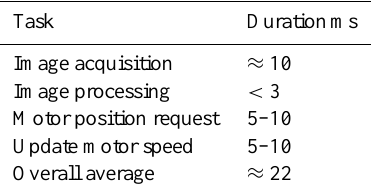
Table 1. Leading contributions to the duration of fine-tracking con- trol cycles of the solar tracker (average values retrieved from house- keeping data logged during the measurement campaign aboard RV Polarstern